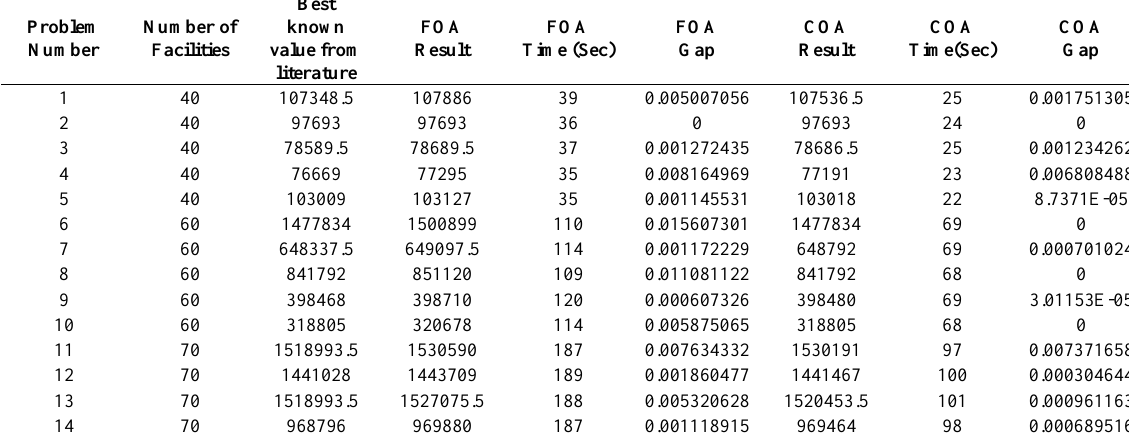
Table 3. Results for problem